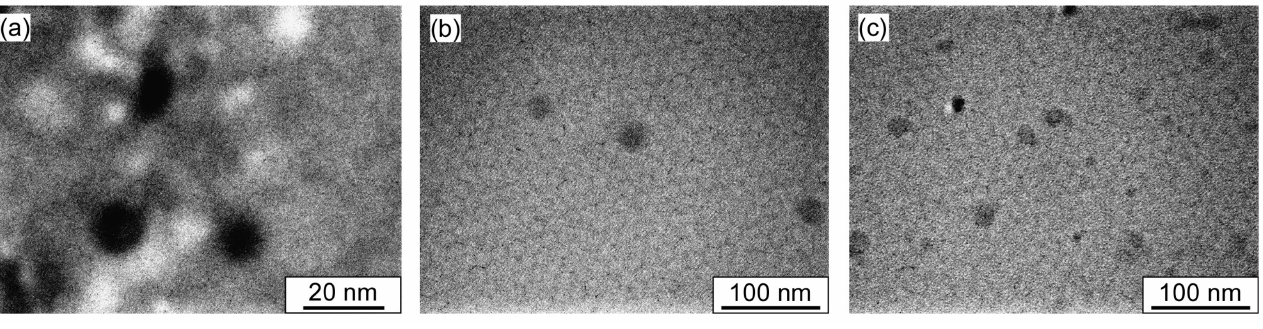
Figure 5. Representative transmission electron microscopy (TEM) images of ( a ) P(MPC/DPAEMA50) 107 , ( b ) PMPC 52 - b -PDPAEMA 56 , and ( c ) an equimolar mixture of the random and block copolymers at a total polymer concentration of 10 g/L in 0.1 M NaCl at pH 10. Table 2. Characteristics of the Random and Block Copolymers and Their Equimolar Mixture Micelles in 0.1 M NaCl at pH 10 and 25 ◦